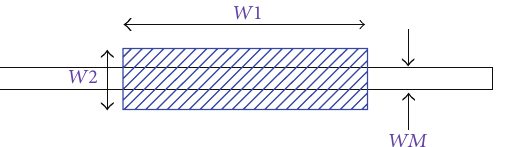
Figure 3: Microstrip line having double-layered substrate and rectangular DGS.